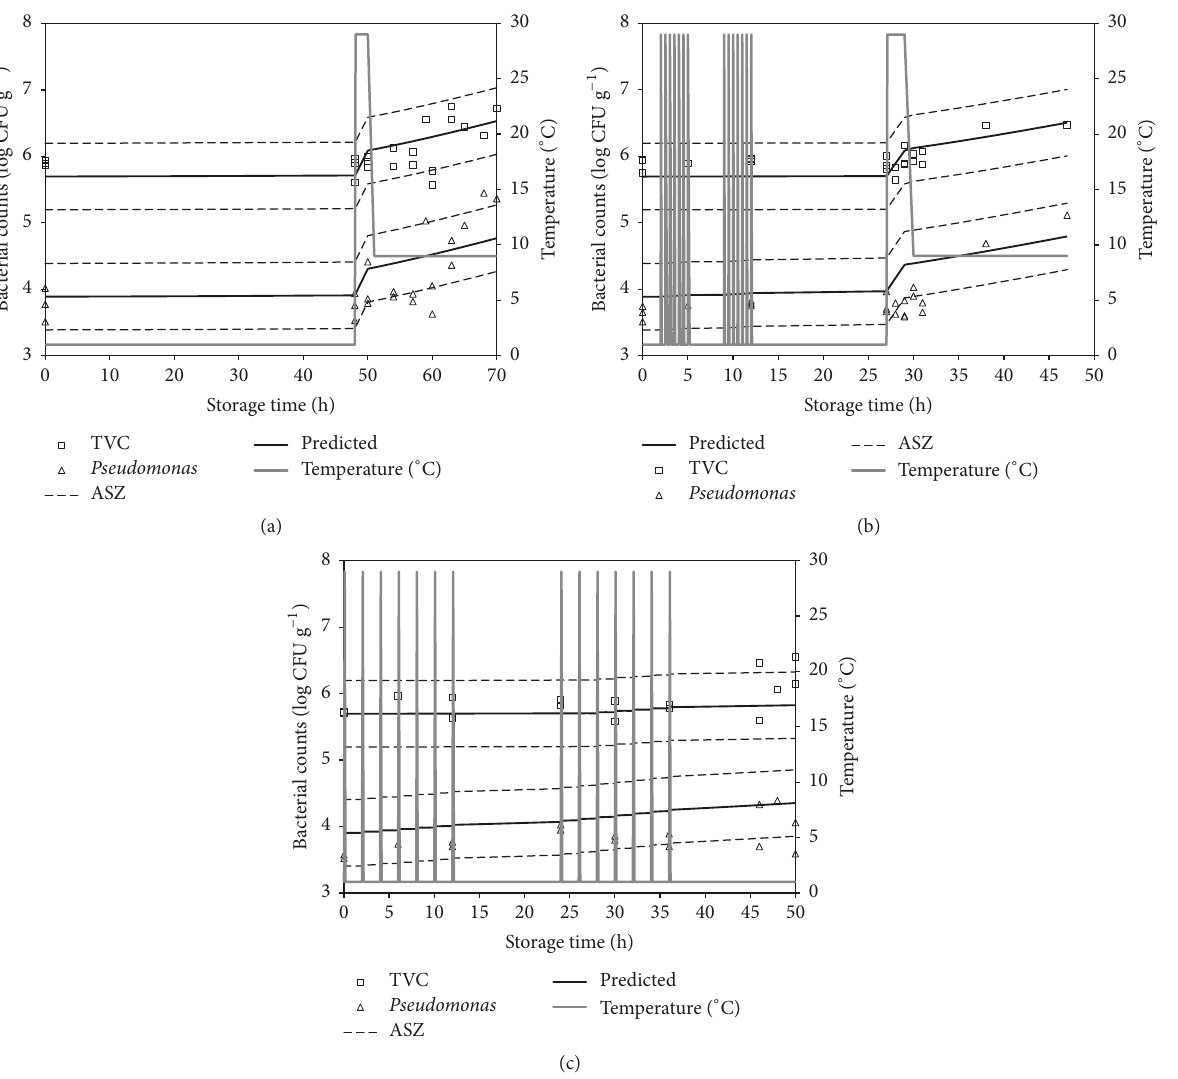
Figure 4: Observed and predicted growth of TVC and Pseudomonas spp. in Pangasius fillets during storage at dynamic temperature regimes: (a) Dynamic 1, (b) Dynamic 2, and (c) Dynamic